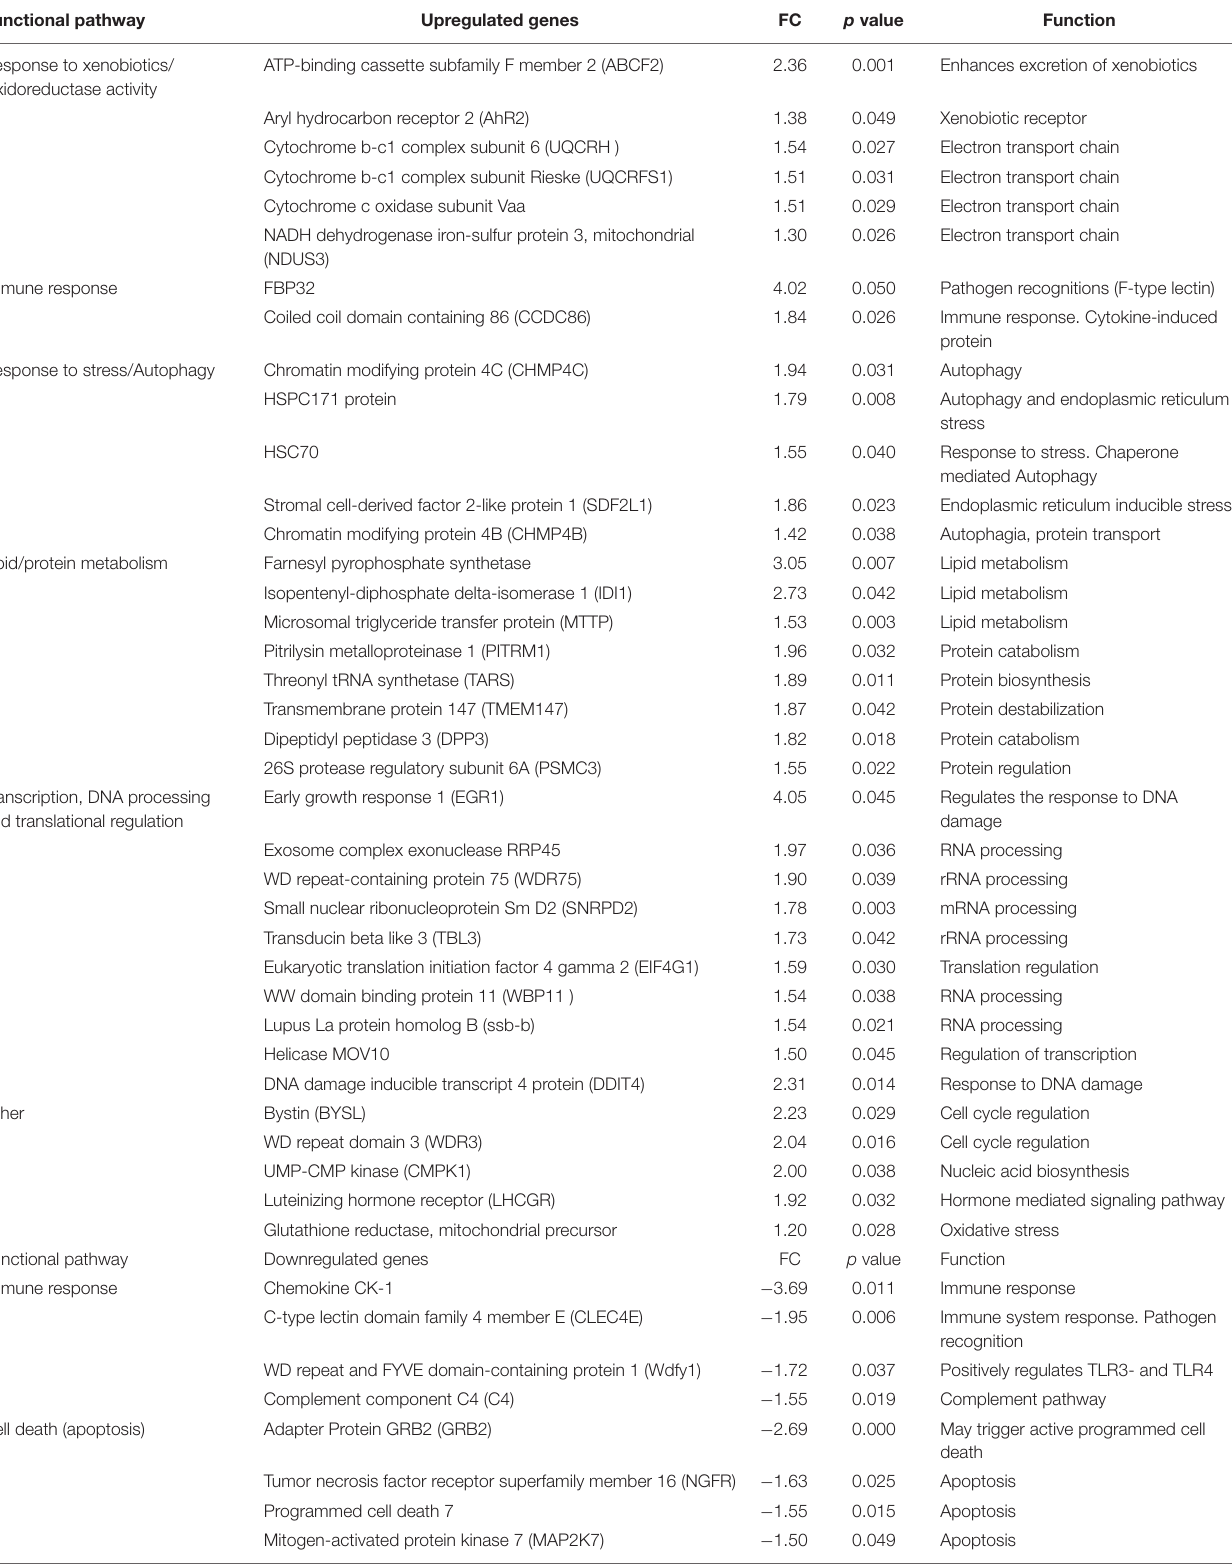
TABLE 2 | Differentially expressed genes for 50 µ g/L